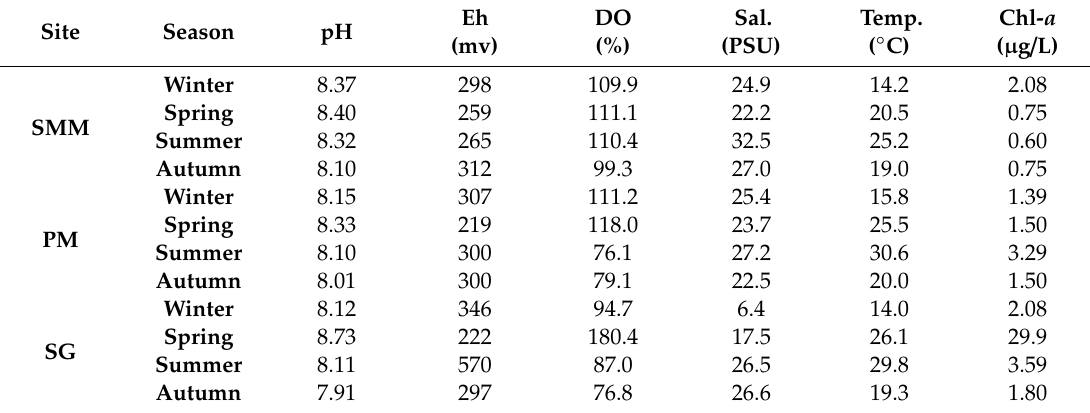
Table 1. Water column environmental parameters of LV sampling sites across sampling periods. SMM: Santa Maria del Mare, PM: Porto Marghera, and SG: San